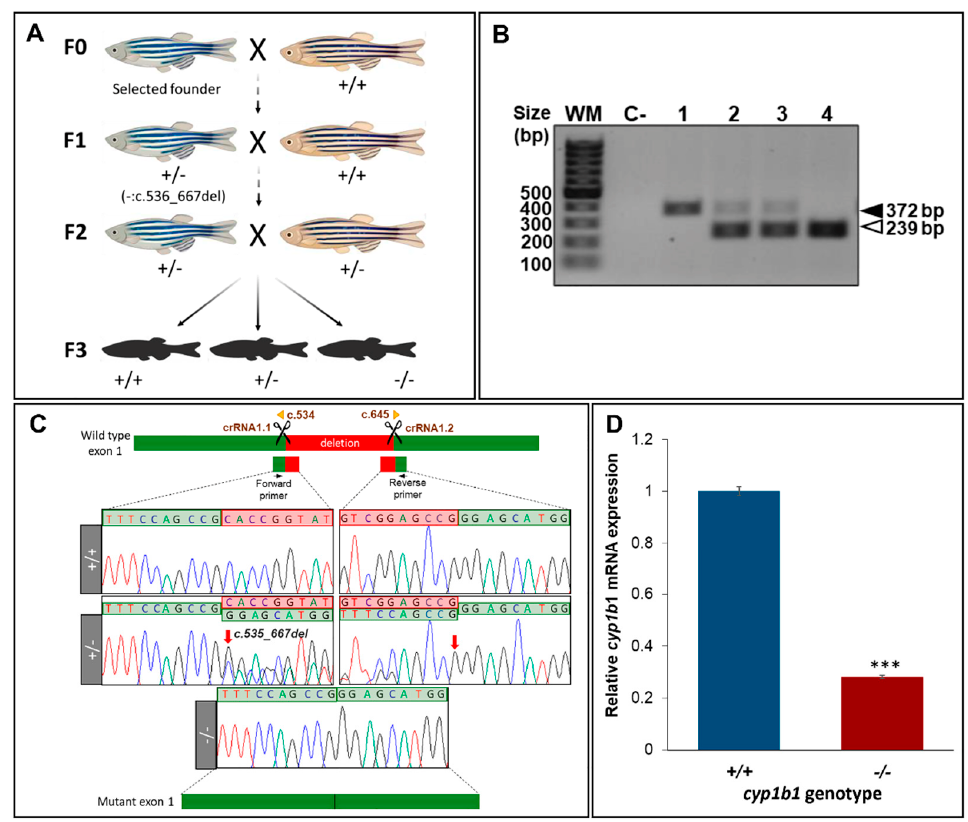
Figure 2. Generation and molecular characterisation of a cyp1b1 -KO zebrafish line using CRISPR/Cas9 genome editing. ( A ) Stepwise procedure followed to generate the KO line. Adult F0 zebrafish were crossed with wildtype AB animals and the offspring were genotyped by PCR and agarose gel electrophoresis to identify germline transmission of cyp1b1 deletions (F0 founders). The selected F0 founder was mated with a wildtype AB animal to obtain mutant F1 heterozygotes that were further outcrossed to segregate off-target mutations in the F2 generation. F2 heterozygotes were inbred to obtain F3 fishes. The scheme was created with the Biorender tool ( https://biorender.com/) (access on 21 April 2021). ( B ). Genotyping by PCR and agarose gel electrophoresis of a 133-bp cyp1b1 d eletion in the F3 generation. Representative examples of the three genotypes are shown. Black arrowhead: wildtype allele (372 bp). White arrowhead: mutant allele (239 bp). ( C ) Sanger sequencing of the selected mutation. The top diagram indicates localization of the identified deletion in cyp1b1 exon 1. Scissors: DNA cleavage sites targeted by the two crRNAs. The numbers correspond to cDNA nucleotide positions. Red arrows in the electropherograms indicate the 5 ′ and 3 ′ ends of the deletion. Deleted nucleotides are indicated in the red background. The diagram in the bottom represents the mutant exon. ( D ) Decreased mRNA levels in cyp1b1 -KO zebrafish. Pools of 45 F4 zebrafish larvae (48 hpf) were used to quantify relative cyp1b1 mRNA levels by RT-qPCR. The values represent the average of three independent experiments carried out in triplicate. Asterisks indicate statistical significance compared to the wild type, p < 0.001 (***).